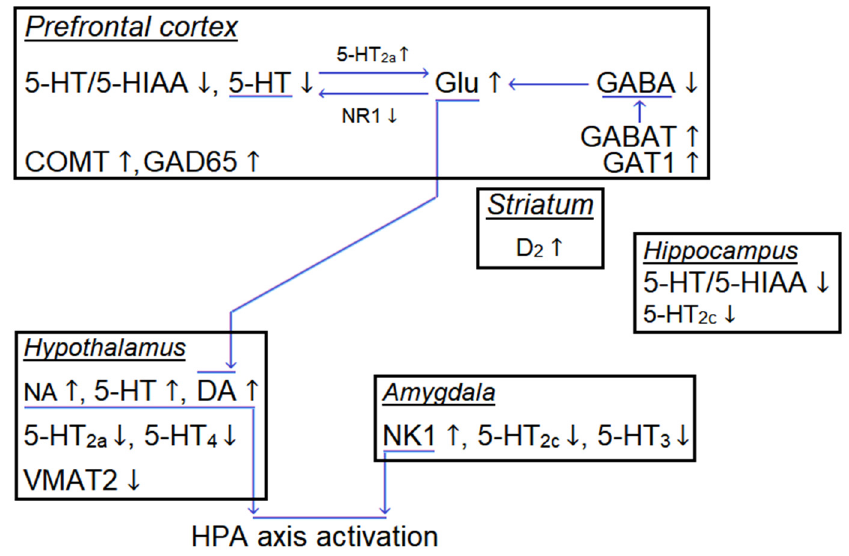
Figure 3. The hypothetical model of nerve tissue response within the boundaries of the studied neurotransmitter systems to the ionizing radiation exposure. Morphological structures with identified changes are circled by rectangles. Vertical arrows near enzymes, transporters, and receptors indicate a change in the level of mRNA expression (up—increase, down—decrease) under the radiation expo- sure; arrows near neurotransmitters indicate a change in total concentration. Long blue horizontal and vertical arrows indicate the stimulating effect of one neurotransmitter system on another. If there is an assumption of the conductor of this effect, it is indicated above or below the arrow. The acting and target neurotransmitter system are underlined by a blue line. DA—dopamine, NA—noradrenalin, 5-